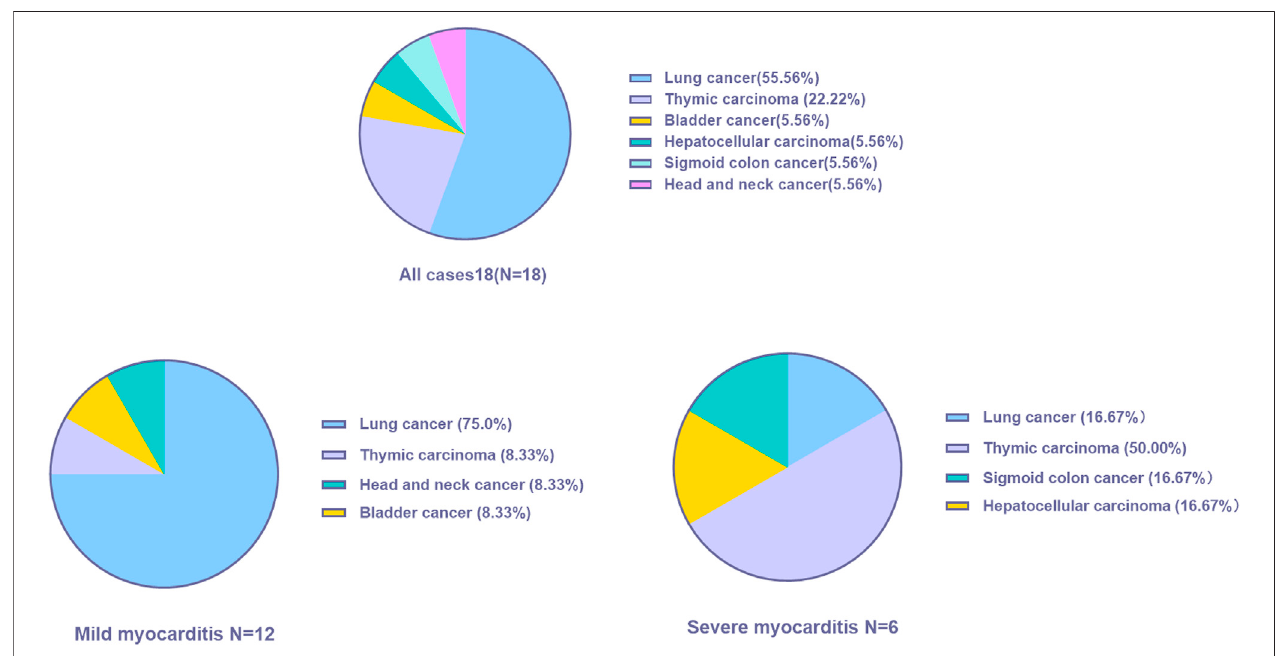
FIGURE 1 | Cancer type distribution of all patients.